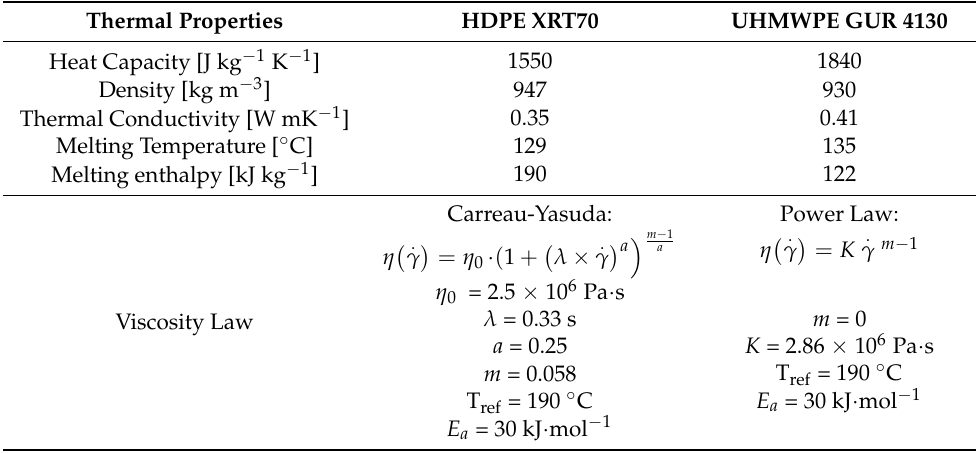
Table 3. Thermal Properties and viscosity laws used in the simulation. Thermal